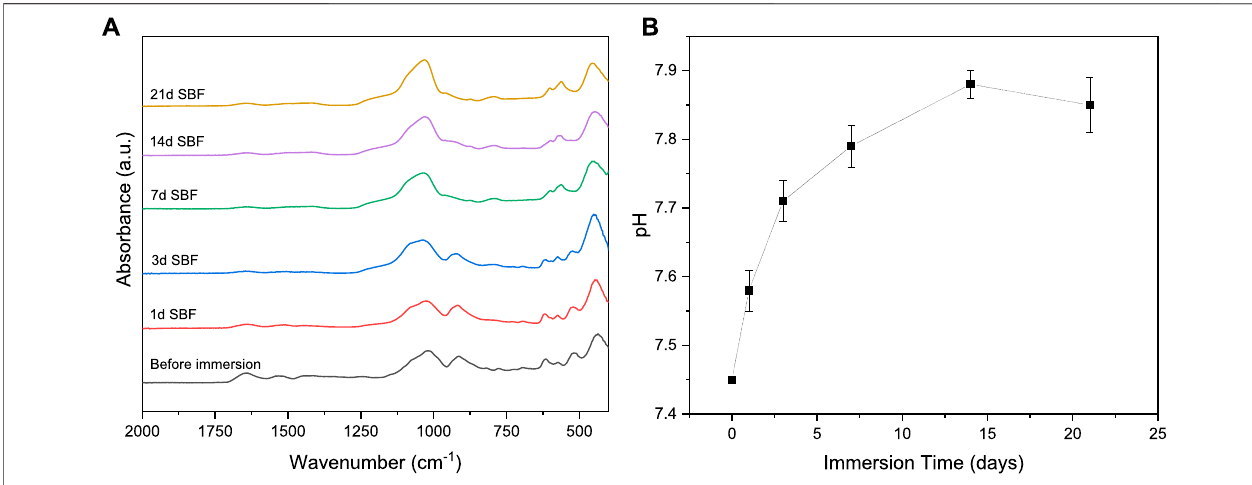
FIGURE 6 | (A) FTIR spectra of zein + MH coated BG scaffolds before and after immersion in SBF, (B) pH values of SBF after immersion of zein +MH coated BG